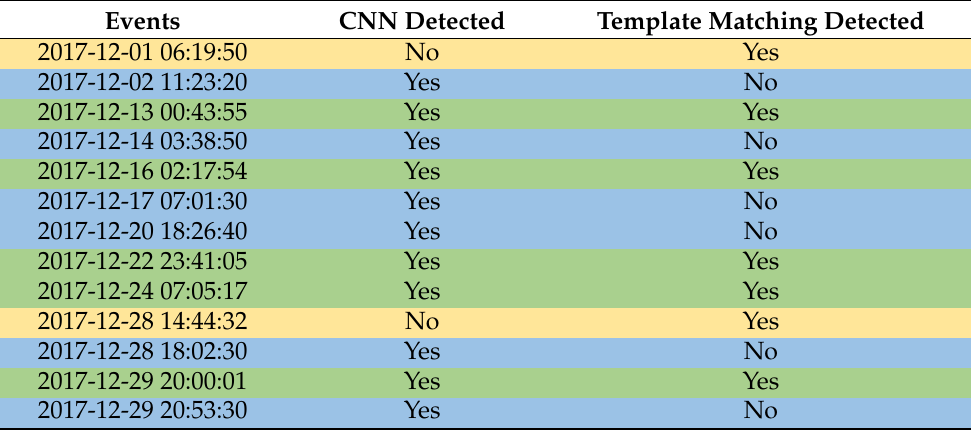
Figure 12. An event detected by template matching and missed by our CNN model at 14:44:32.929 h on 28 December 2017. The event is buried under noise, and the network was not trained on such event waveforms. Only the vertical waveforms are shown for illustration. The waveforms are displayed in sequence with the waveform from the shallowest sensor at the top and the one from the deepest sensor at the bottom. Table 3. Summary of uncataloged events picked by template matching and the trained CNN model. Events picked by both template matching and CNN are highlighted in green. Events picked by template matching only are highlighted in yellow, and events picked by CNN only are highlighted in